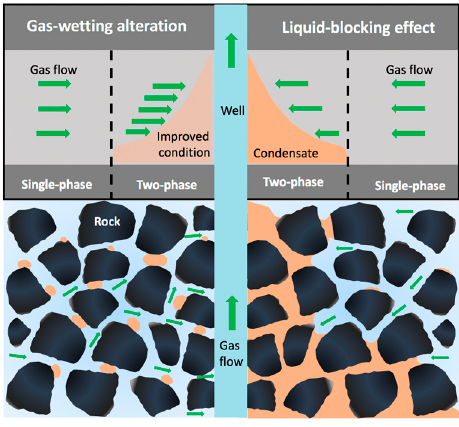
Figure 2. Sketch of mitigation of liquid-blocking e ff ect by gas-wetting alteration in gas condensate